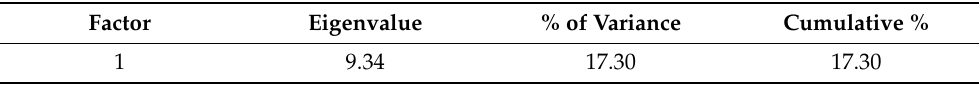
Table 2. Eigenvalues, percentages of variance, and cumulative percentages for factors for the 23-item variable set.